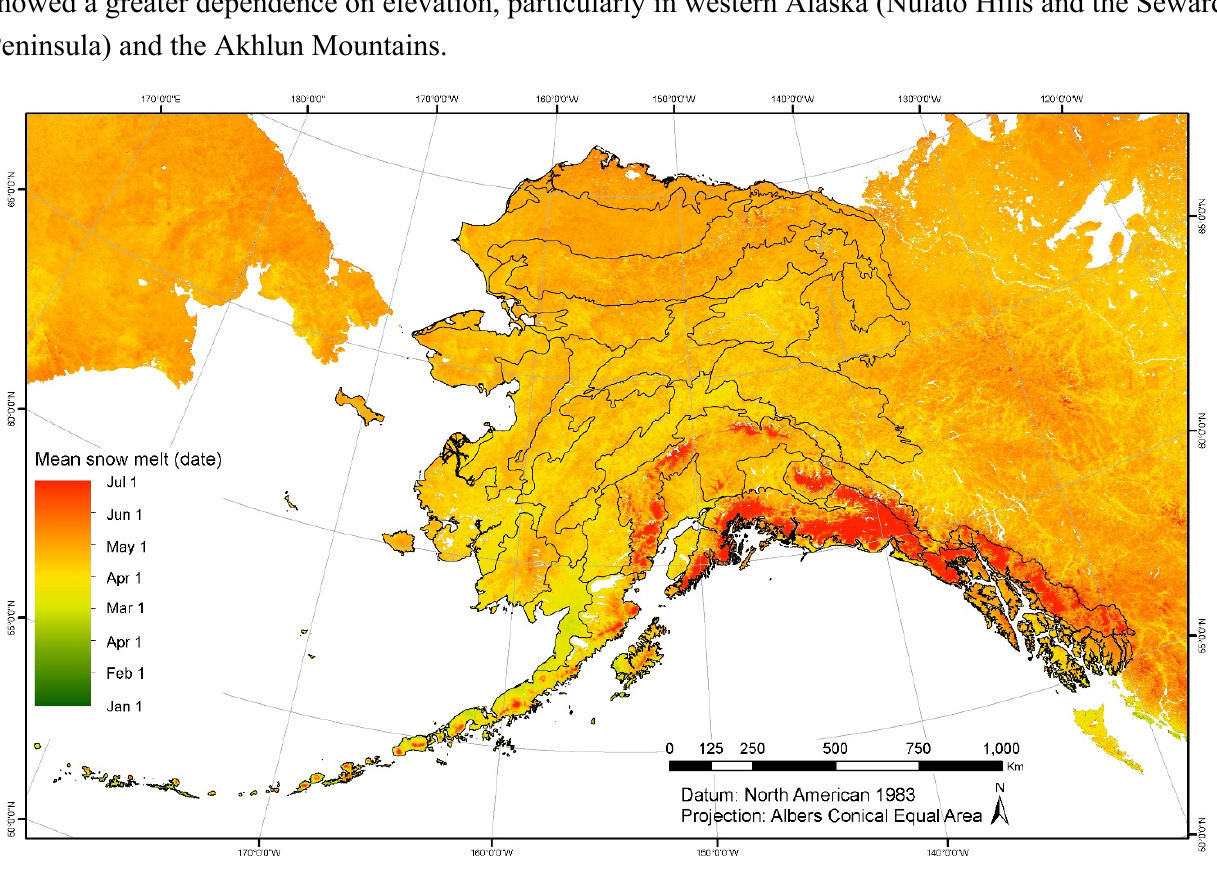
Figure 8. Mean last snow date (LSD) for the full snow season during 2001–2013 snow years with respect to ecoregion [33]. Ecoregion data courtesy of U.S. Geological